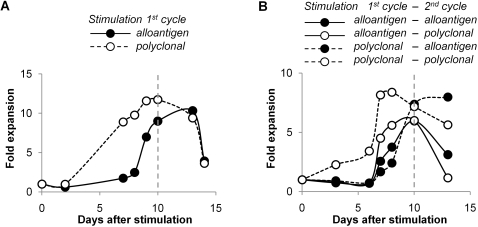
Determination of optimal length of primary and secondary Treg expansion cycles.(A) Optimal length of primary Treg expansion cycles. Treg were stimulated with CFSE-labeled alloantigen (solid line, solid circle) or polyclonal (dotted line, open circle) stimulus in the presence of IL-2 and IL-15. At indicated time points, Treg numbers were counted by FACS (excluding CFSEpos allogeneic stimulator cells) and related to Treg numbers at initial set up. (B) Optimal length of secondary Treg expansion cycles. Treg were primed with alloantigen (solid lines) or polyclonal (dotted lines) stimulation as indicated in the presence of IL-2 and IL-15 and rested for 2 days prior to restimulation. Cells were restimulated with CFSE-labeled alloantigen (solid circles) or polyclonal stimulus (open circles) in the presence of IL-2 and IL-15. At indicated time points, Treg numbers were counted by FACS (excluding CFSEpos allogeneic stimulator cells) and related to Treg numbers at initial set up. Data are representative of three independent experiments.